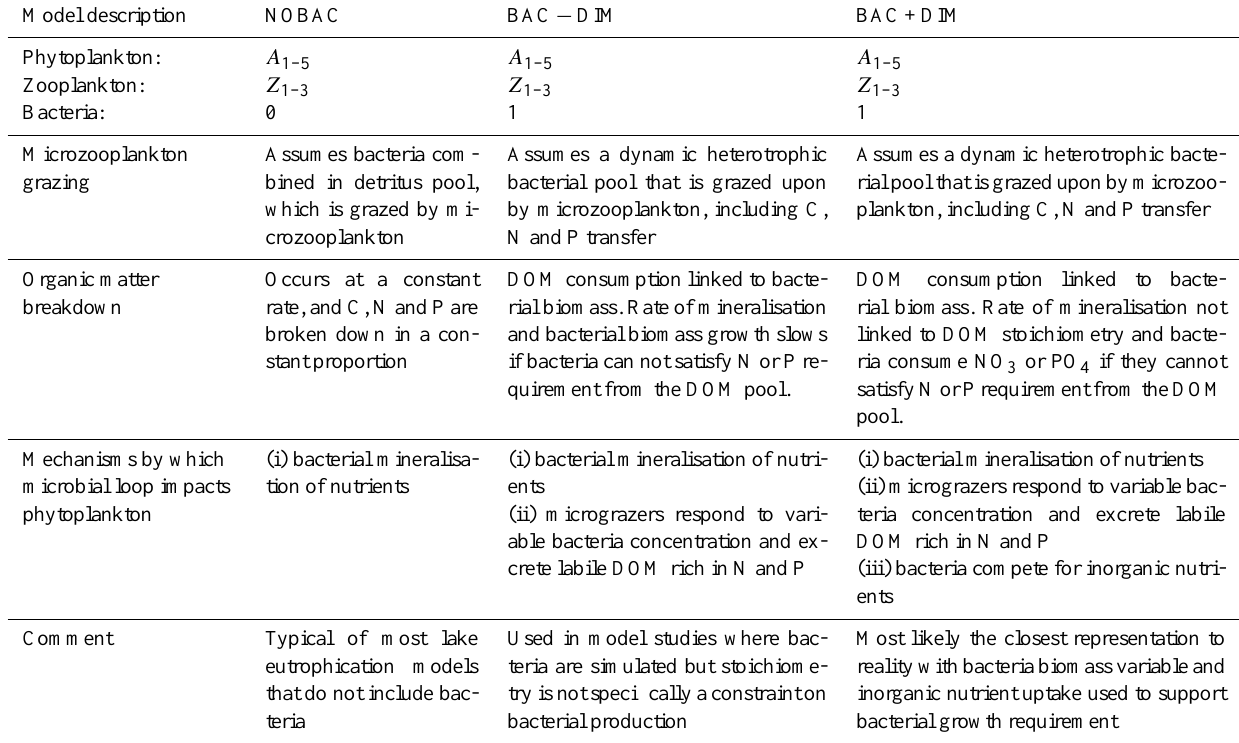
Table 2. Summary of three microbial loop simulations configured. Model